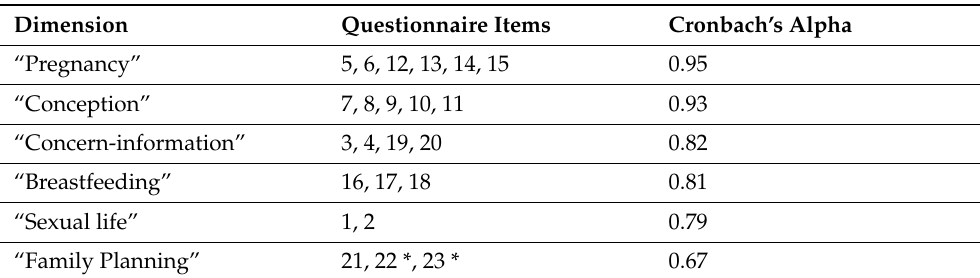
Table 3. Dimensions of the questionnaire. Dimension Questionnaire Items Cronbach’s Alpha “Pregnancy” 5, 6, 12, 13, 14, 15 0.95 “Conception” 7, 8, 9, 10, 11 0.93 “Concern-information” 3, 4, 19,